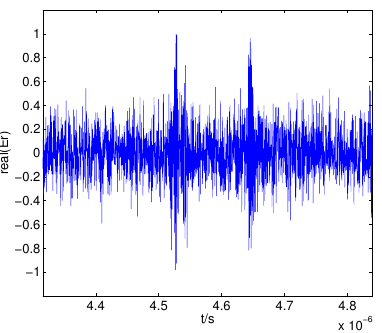
Figure 7. Received signal for a signal-to-noise ratio of 5 dB.